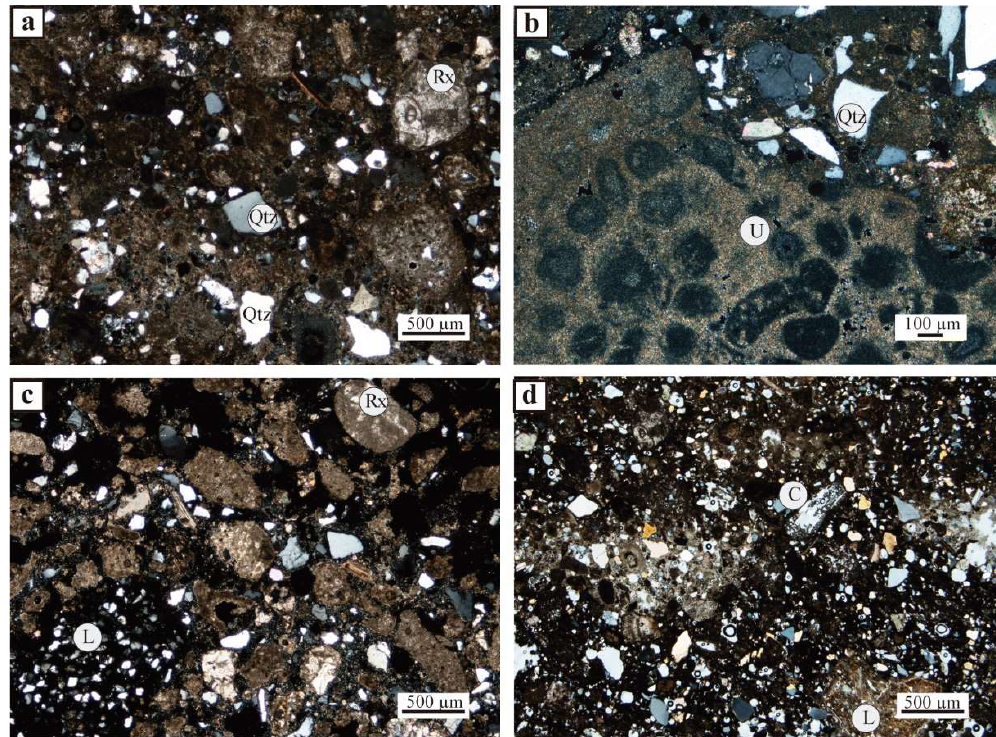
Figure 4. Photomicrographs showing the textural heterogeneity of historic lime mortars from Portilla Castle. ( a ) Mortar with rock fragments, lumps, and quartz grains. ( b ) Fragments of unburnt